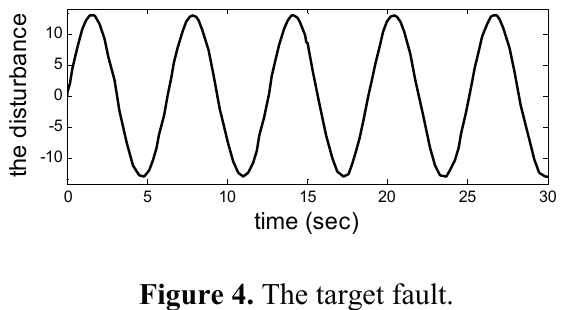
Figure 4. The target fault.